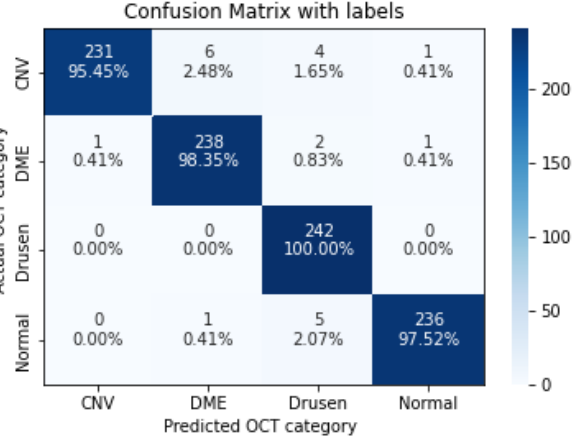
Figure 10. The confusion matrix of 11 layers model, with numbers and